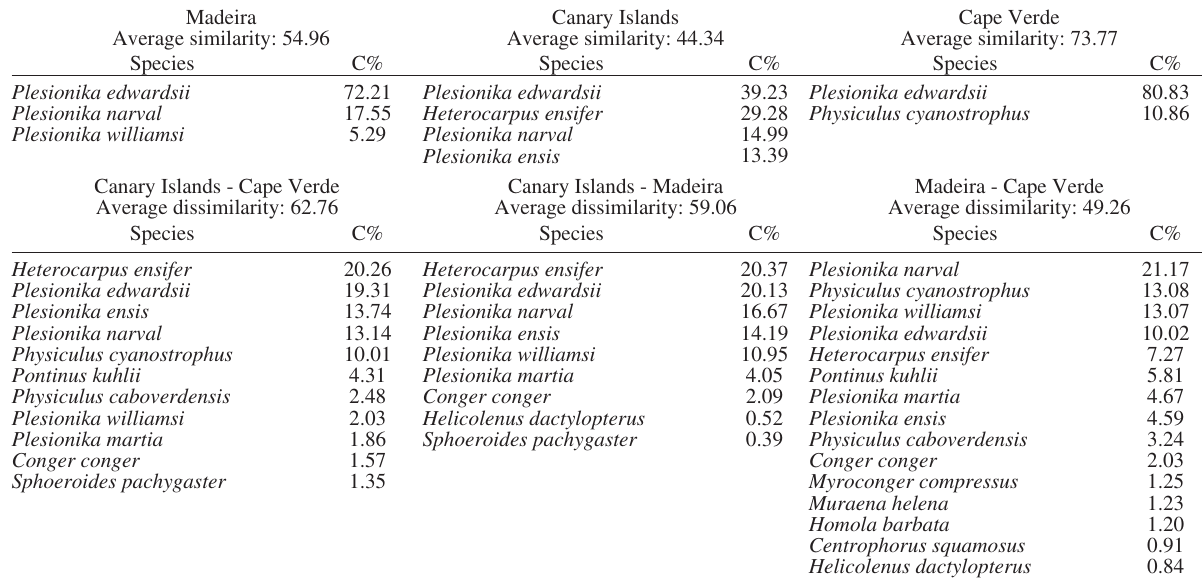
Table 3. – Results of the SIMPER routine to analyse the contribution (C, in %; cut off=90.0%) in abundance of typifying species to within- group similarity and showing species that most contribute to intergroup dissimilarity. Madeira Canary Islands Cape Verde Average similarity: 54.96 Average similarity: 44.34 Average similarity: